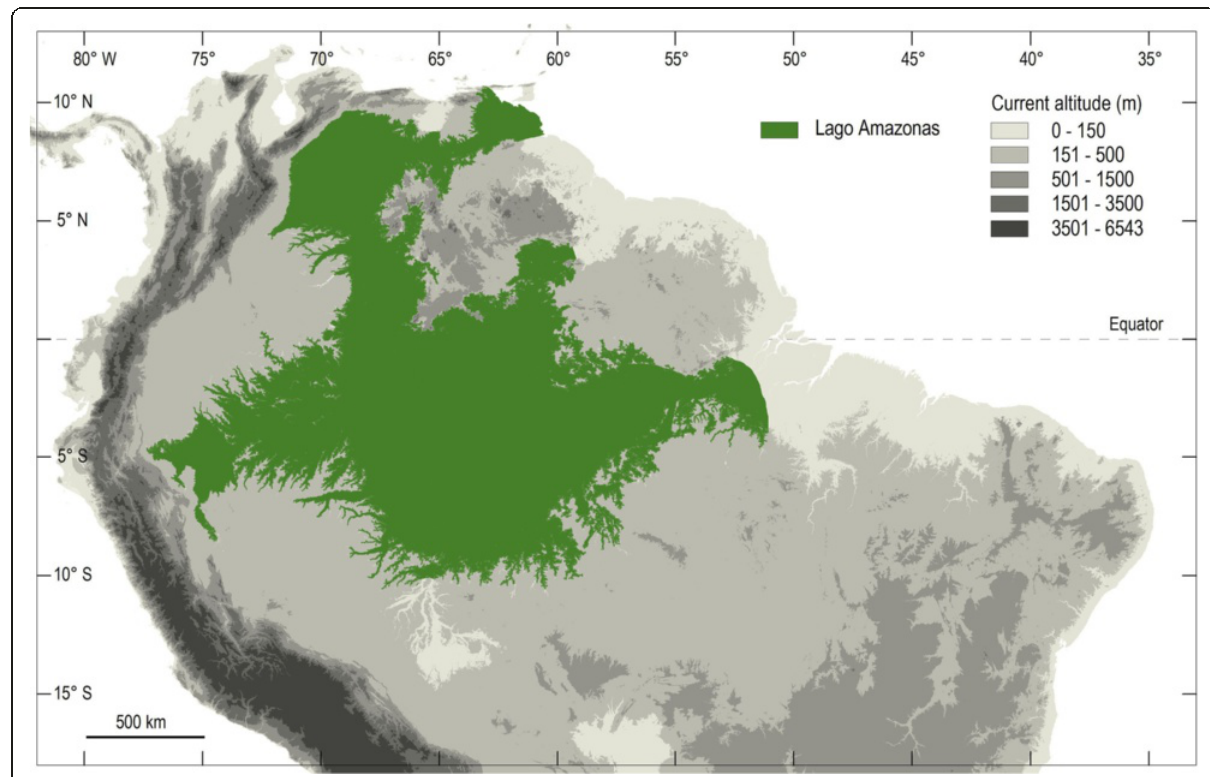
Fig. 24 A hypothesized reconstruction of Lago Amazonas with a northern outlet through the Orinoco Valley (modified from Frailey et al.